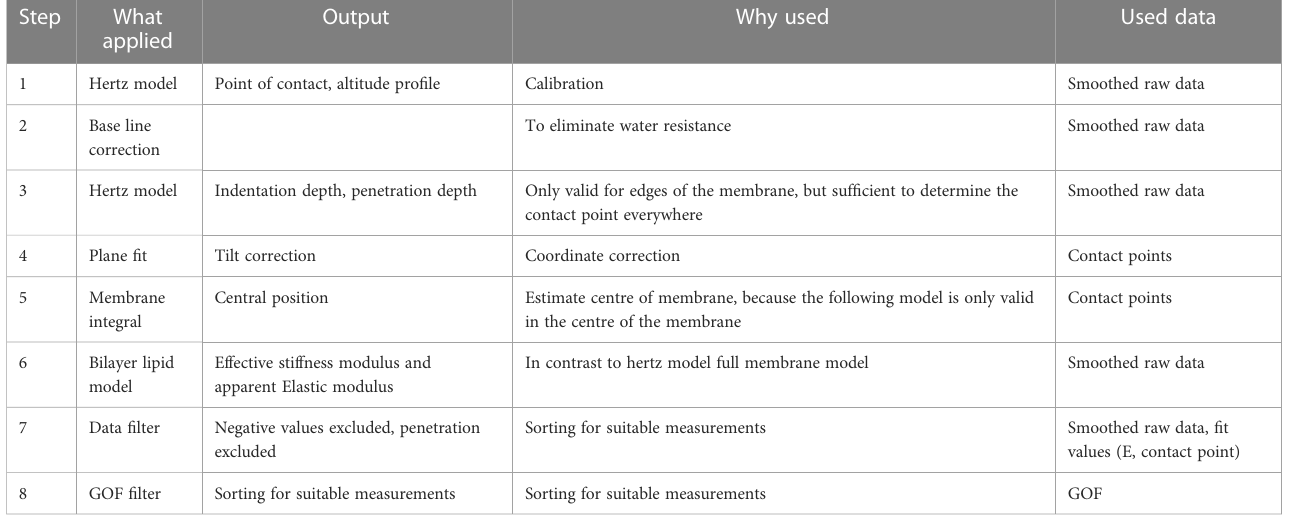
TABLE 1 Overview over the AFM QI data fi tting steps to get the parameters Effective stiffness modulus and Apparent elastic